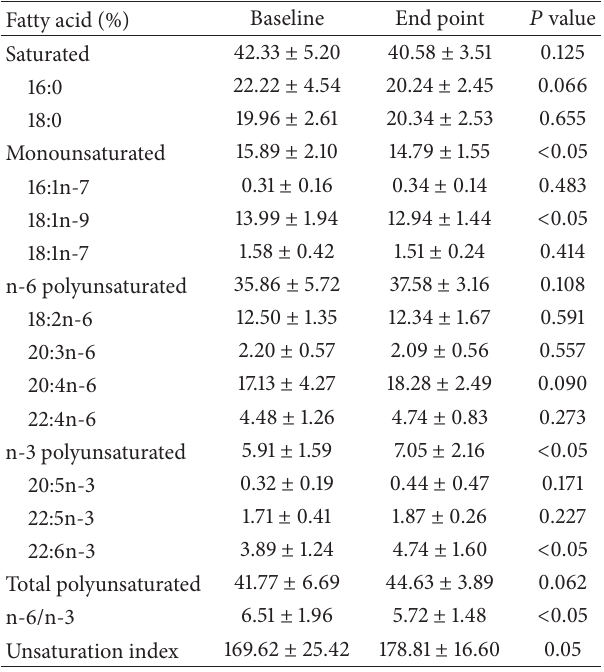
Table 2: Membrane fatty acid profile in